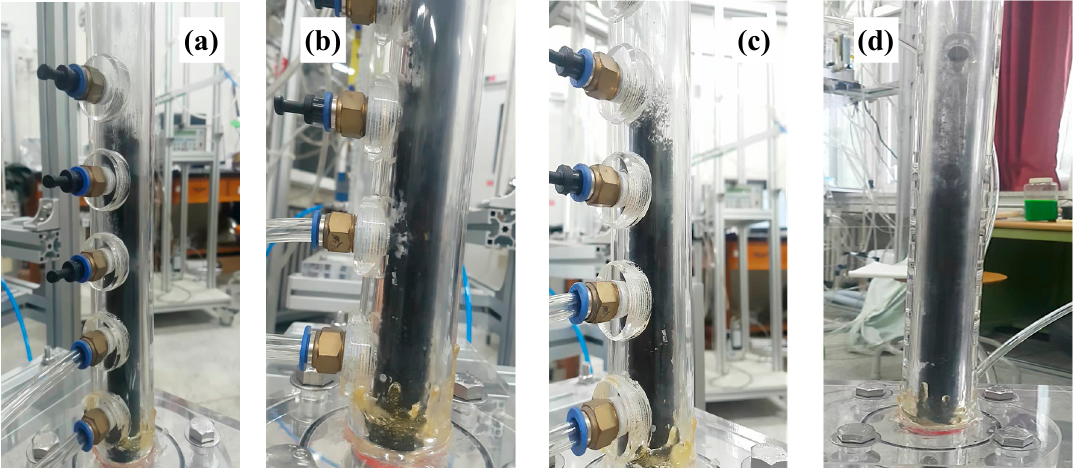
Figure 7. Fluidization behavior above U mf of the CNT microbeads: ( a ) case I at U mf , ( b ) case I at U g = 0.61 m/s (1.7 U mf ), ( c ) case II at U mf and( d ) case II at U g = 0.61 m/s (1.3 U mf ).